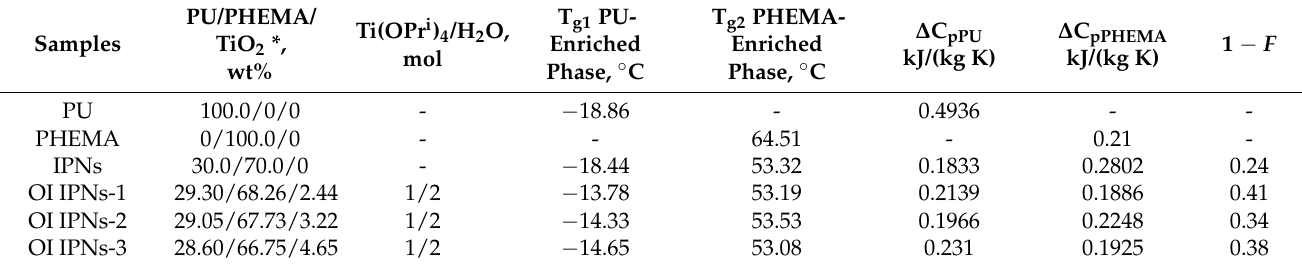
Table 2. Thermophysical parameters of relaxation transitions of IPNs and OI IPNs.